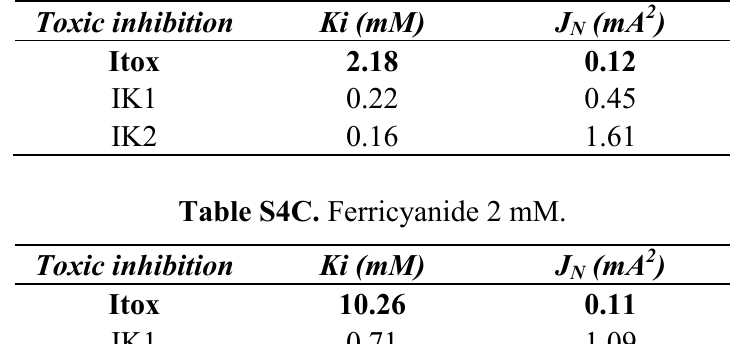
Table S4B. Ferricyanide 1 mM.